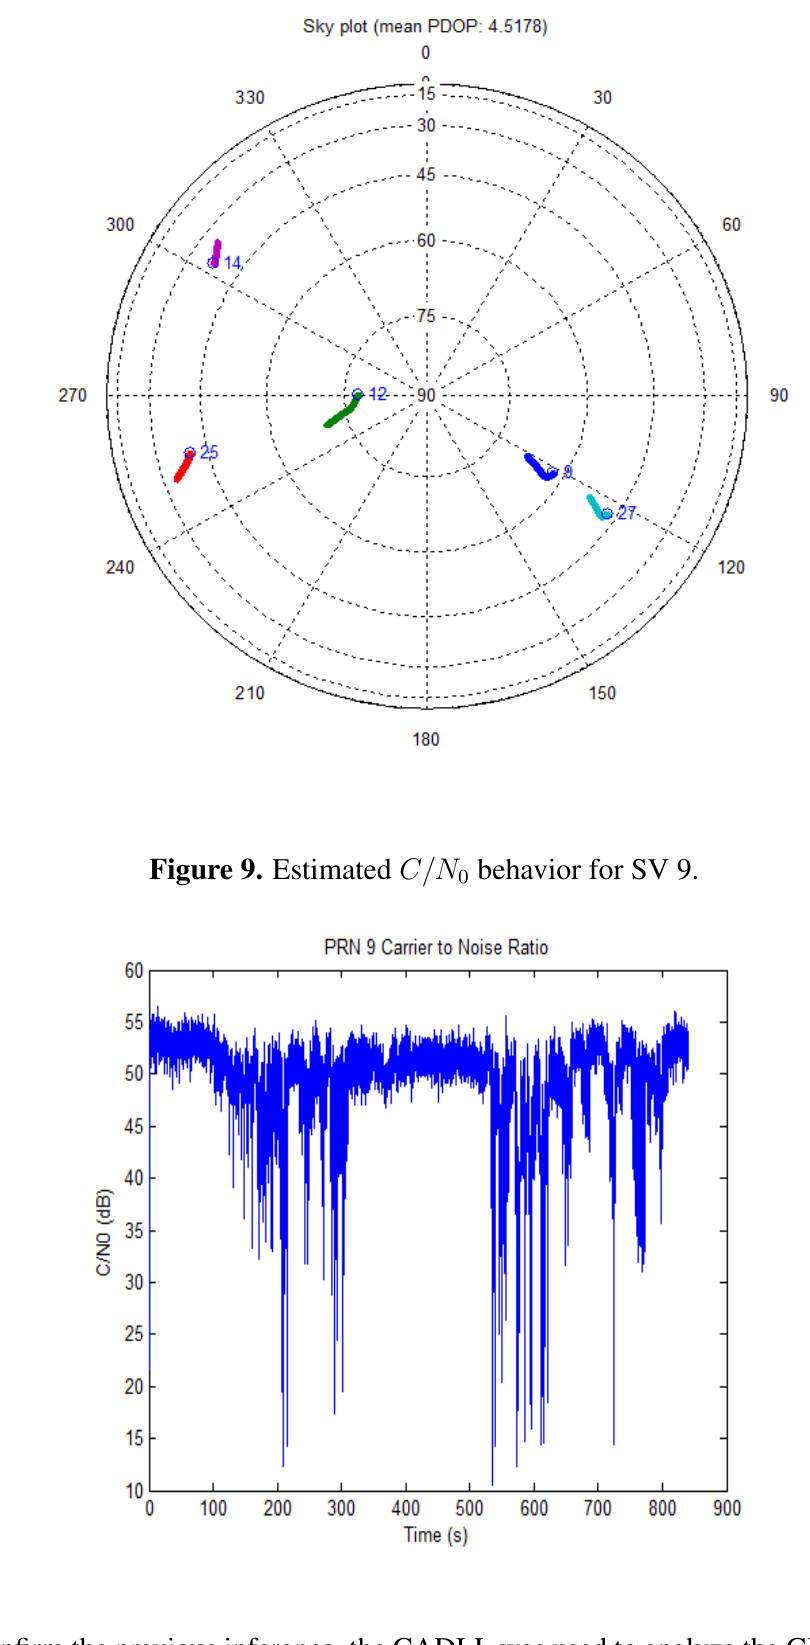
Figure 8. Sky plot for the acquired satellites.